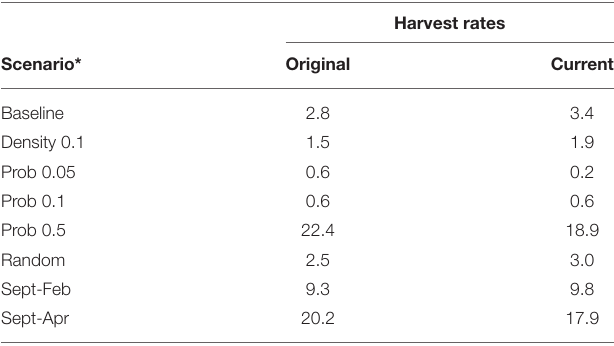
TABLE 1 | Average number of cattle herd breakdowns per year under the original and current deer harvest rates after 30 simulated years.